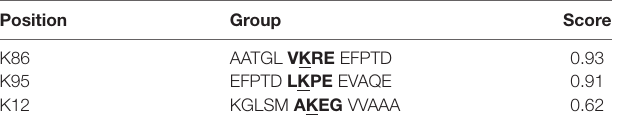
TABLE 3 | β -synuclein ( β Syn) putative sumoylation